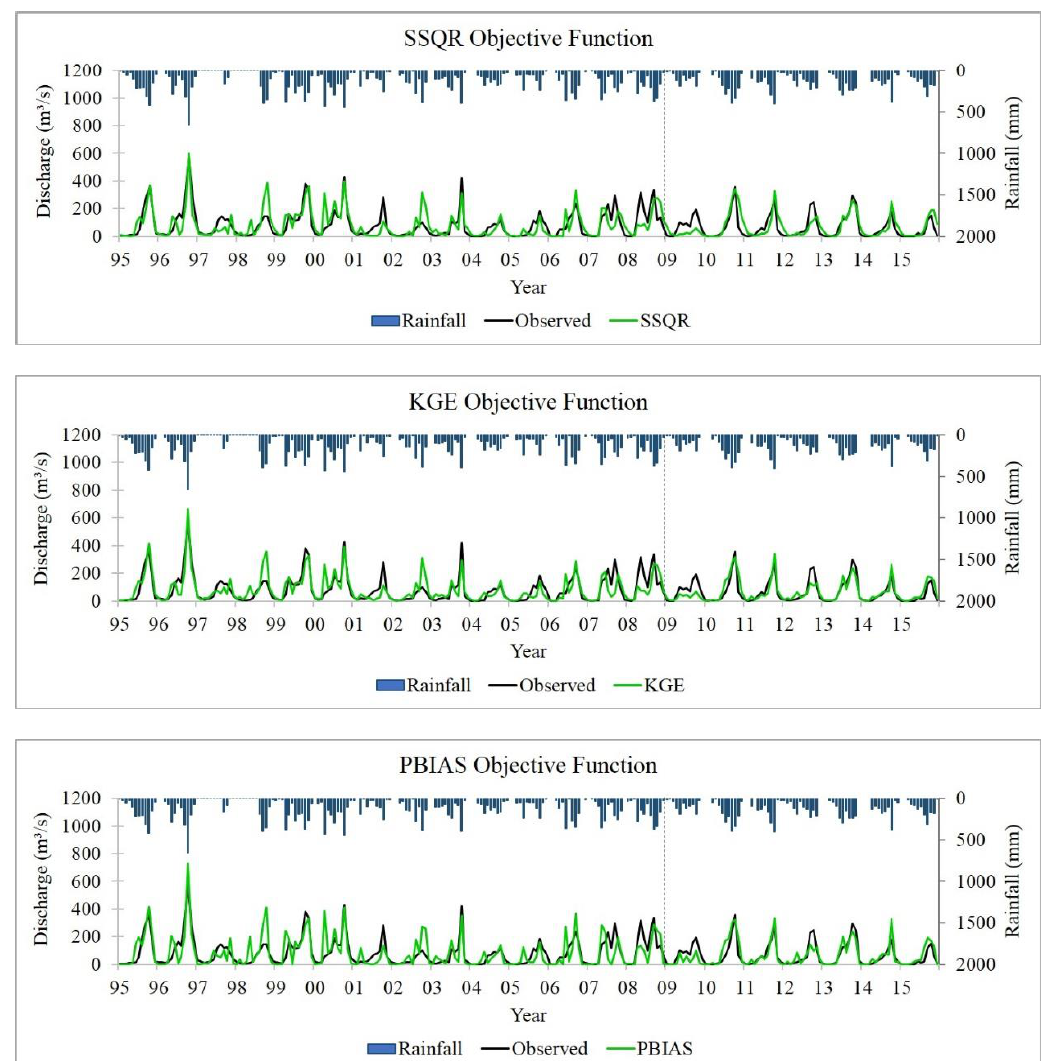
Figure 3. Monthly simulated and validated discharges of different objective functions compared with observed data.